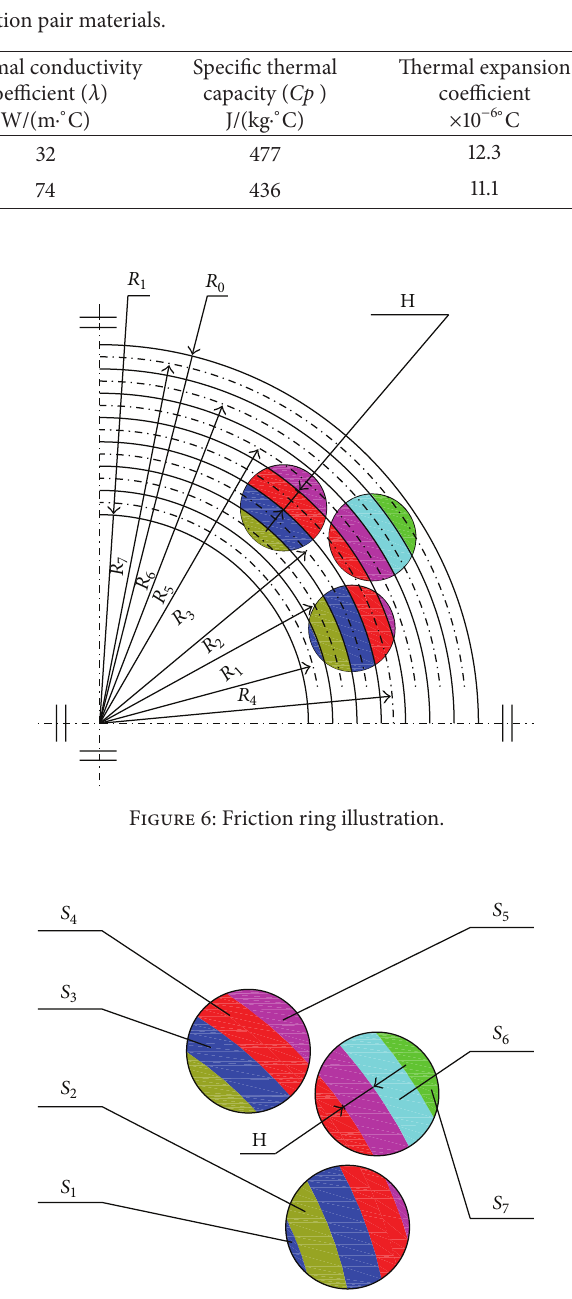
Figure 7: Areas of friction